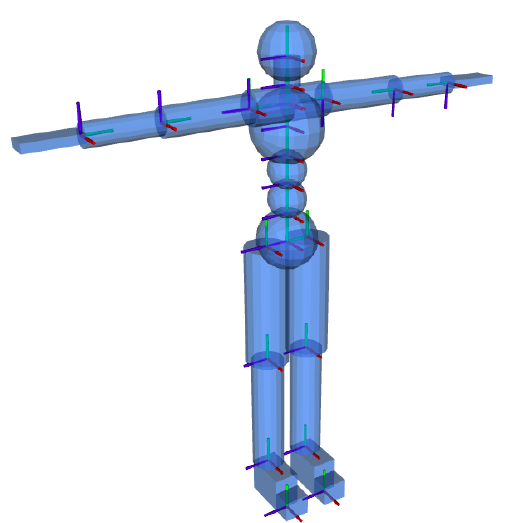
Figure 2. Digital Human Model (DHM) with 66 degrees of freedom. For each DHM’s link we display its origin axis ( x in red, y in blue and z in